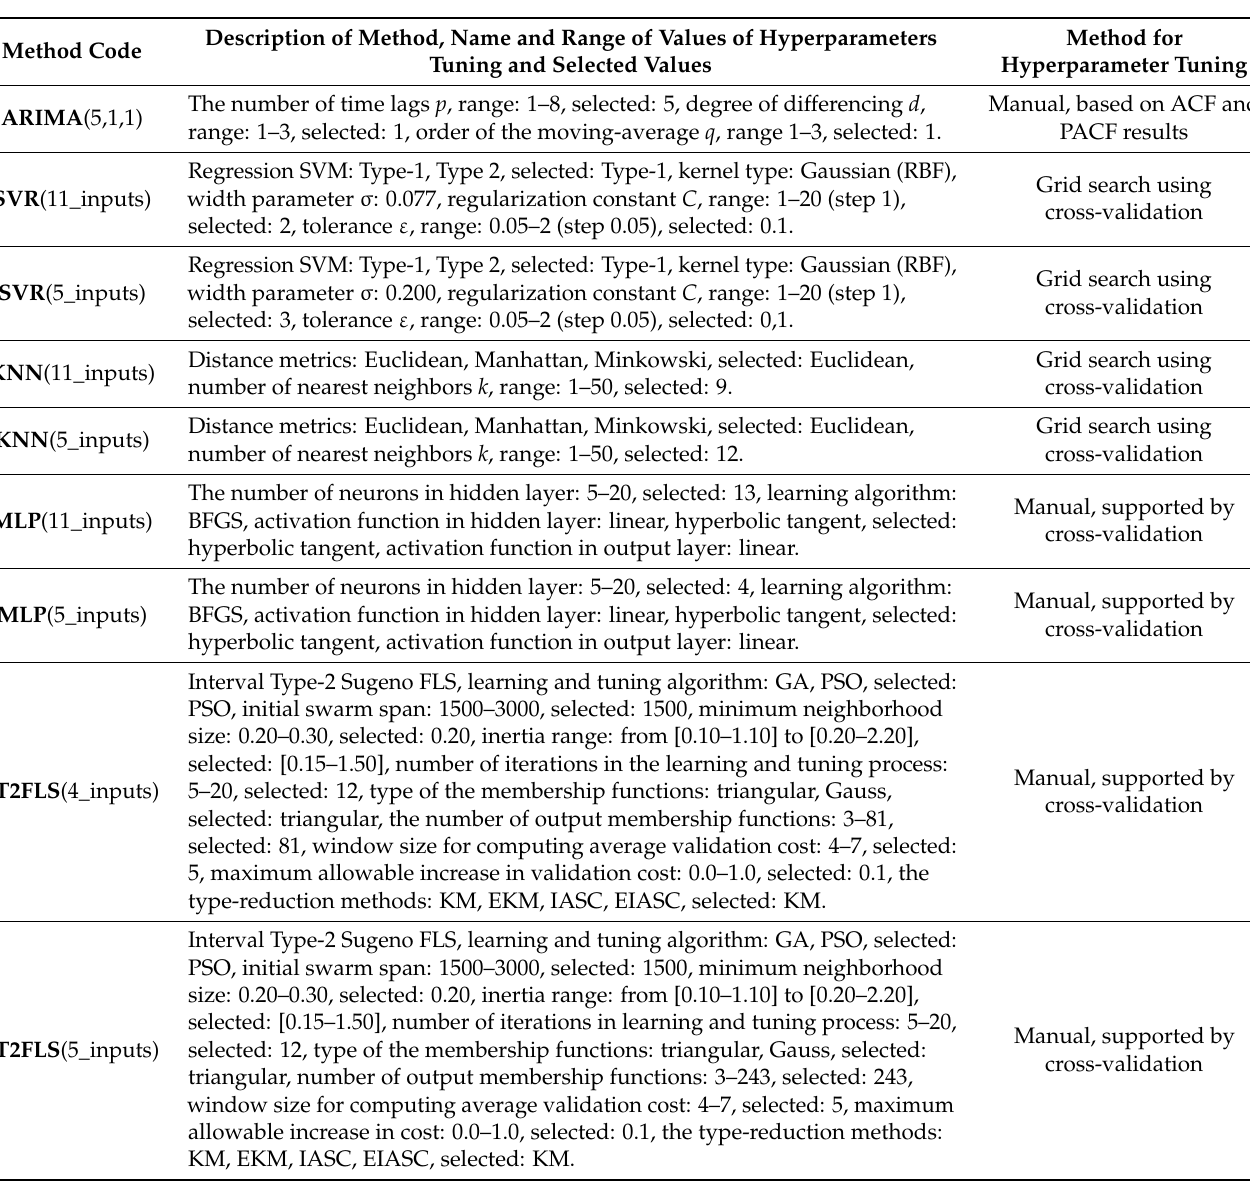
Table A1. Results of hyperparameter tuning for proposed single methods for time series No. 1. Description of Method, Name and Range of Values of Hyperparameters Method Code Tuning and Selected Values